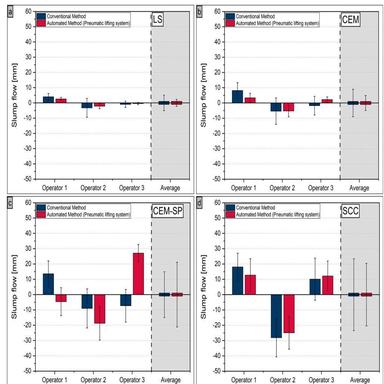
Difference between operators and mean results of slump flow, including the standard deviation for the (a) LS (b) CEM (c) CEM-SP mixes and the (d) SCC.